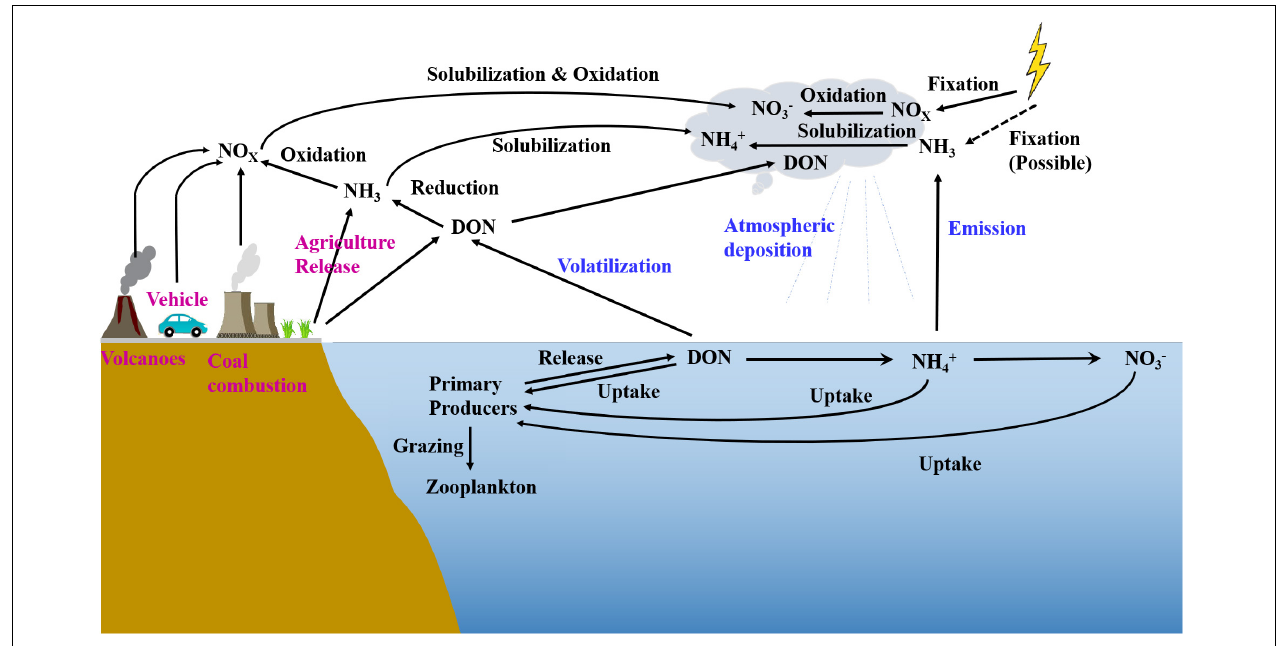
FIGURE 7 | Sketch of N sources, atmospheric transport, and reaction pathways in oceanic precipitation events (modified from Cao et al.,